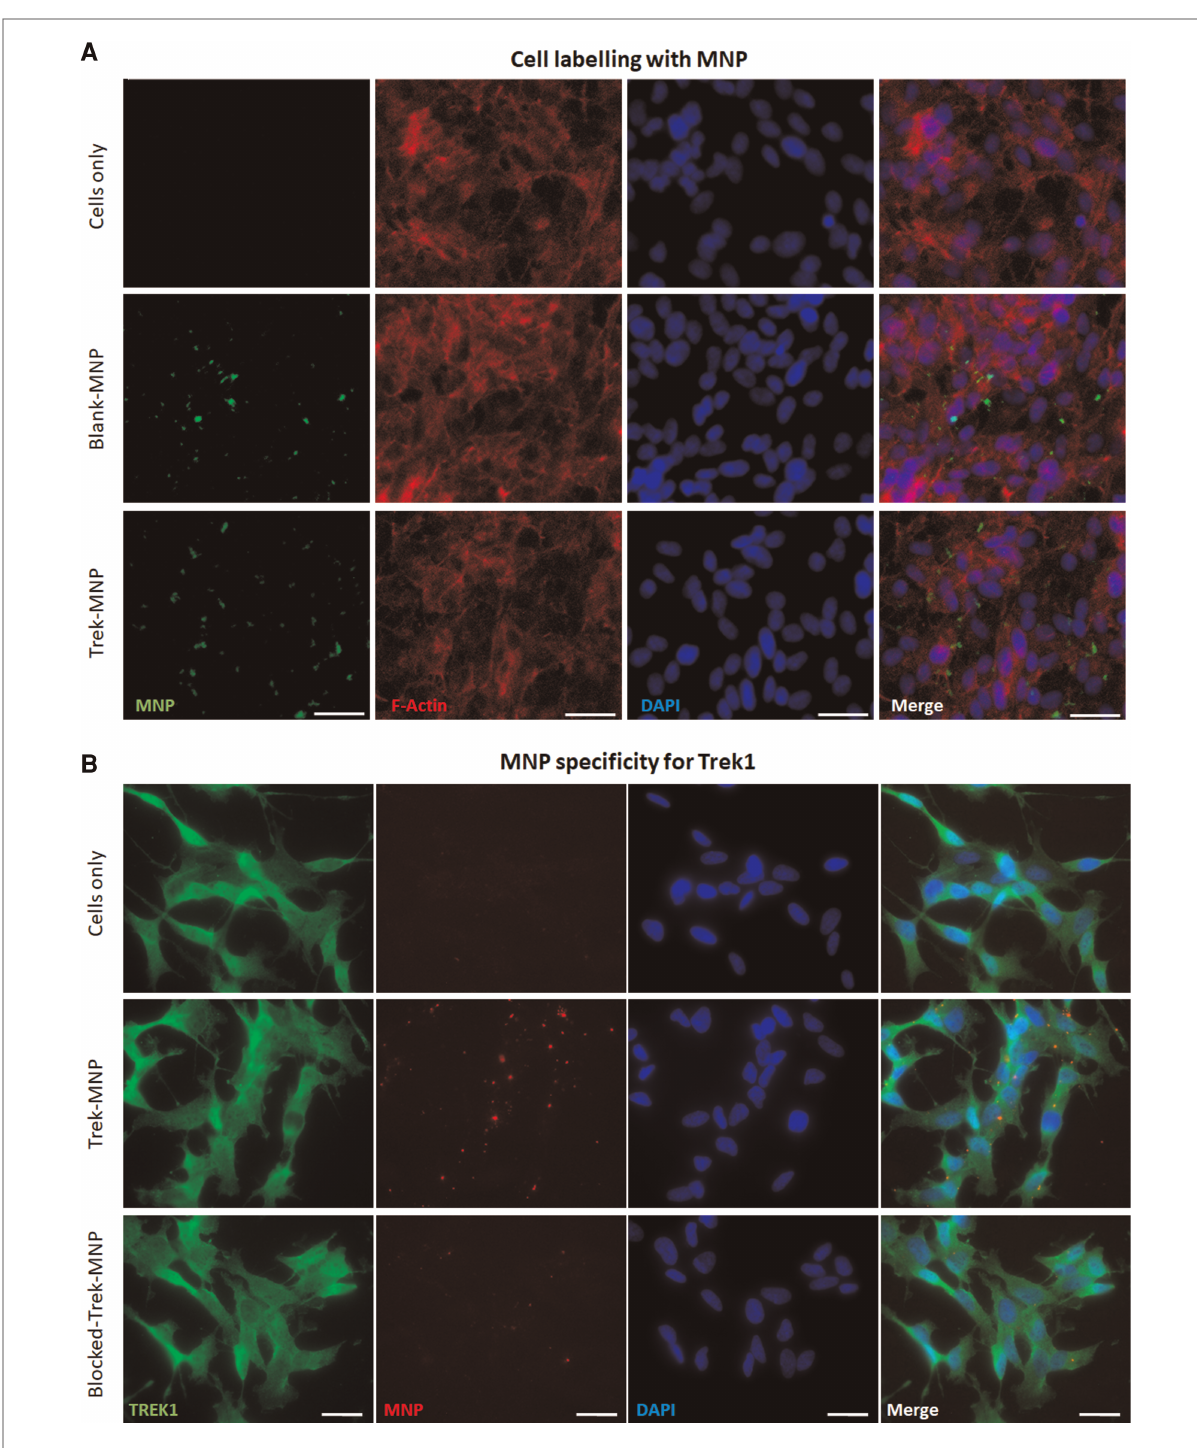
FIGURE 2 TREK-MNP labelling of SH-SY5Y. ( A ) Immuno fl uorescent microscopy showing unlabelled cells (top row) and cells labelled with Blank-MNP (middle row) or TREK-MNP (bottom row). MNP are shown by Dextran staining (green), cell cytoskeleton is shown by Actin staining (red) and cell nuclei are shown by DAPI staining (Blue). Images representative of n =3, scale bar represents 25 μ m. ( B ) Immuno fl uorescent microscopy showing unlabelled cells (top row), cells labelled with fl uorescent TREK-MNP (middle row) or fl uorescent TREK-MNP pre-blocked with a TREK blocking peptide (bottom row). TREK1 channels are shown in green, MNP are shown in red and cell nuclei are shown by DAPI staining (Blue). Images representative of n =3, scale bar represents 50 μ